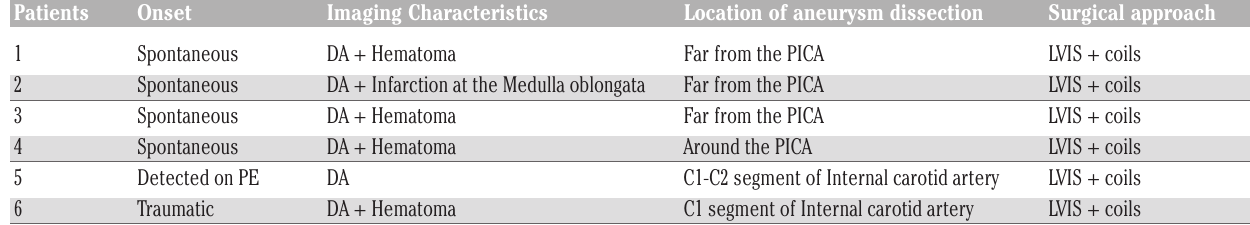
Table 1. General information of